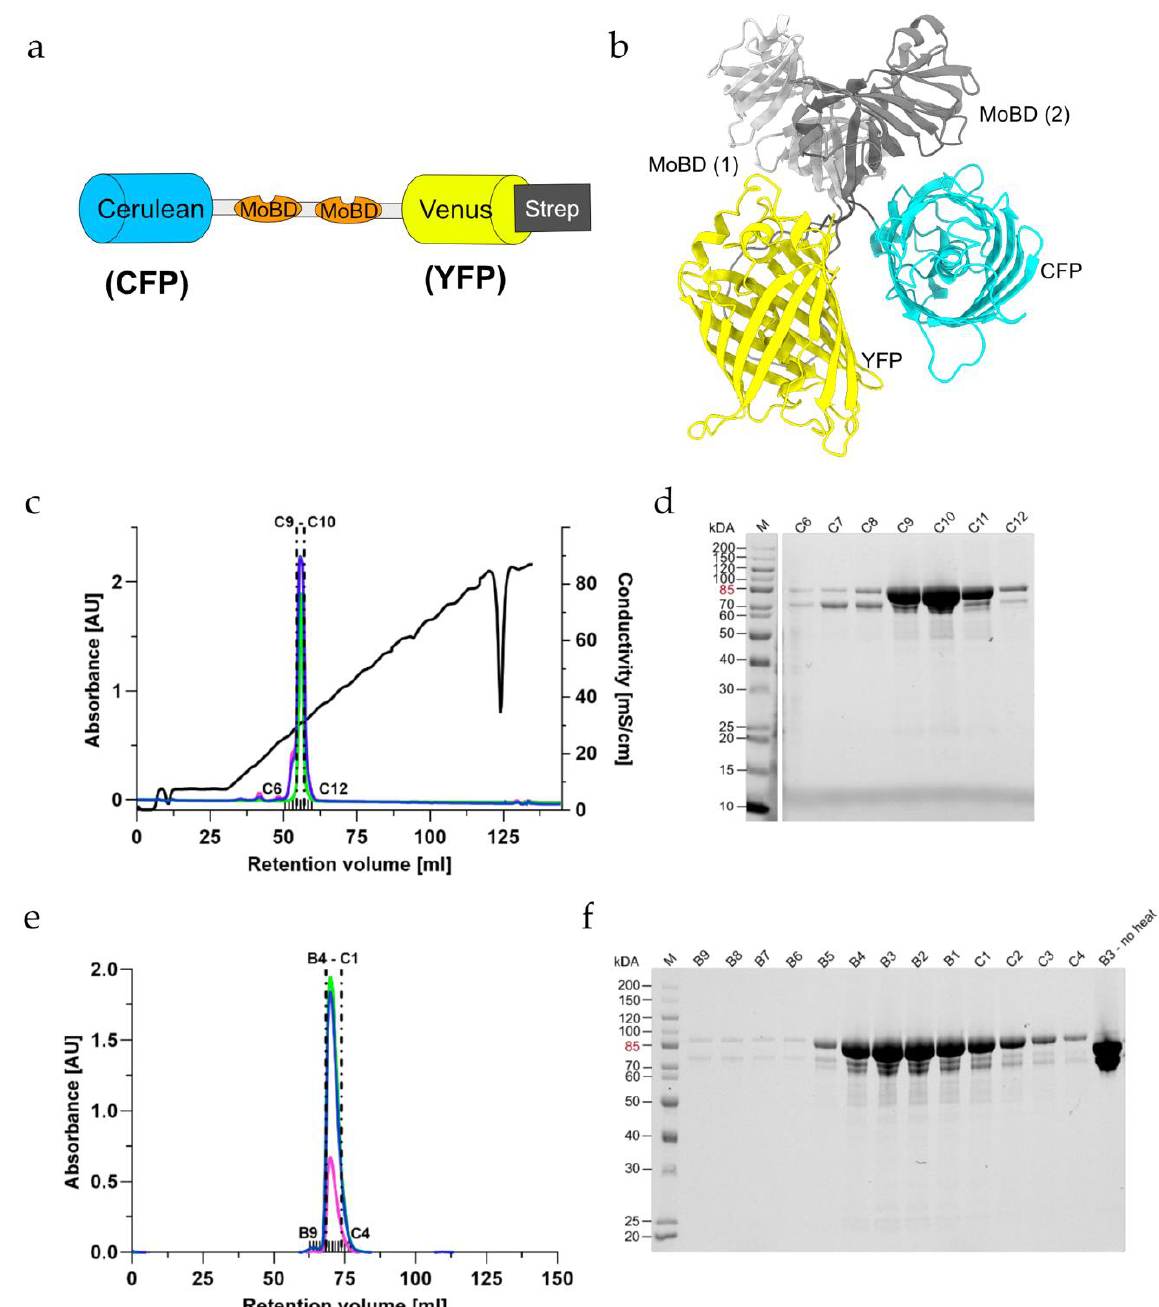
Figure 1. Purification of the MolyProbe-Strep protein: ( a ) Schematic description of the MolyProbe- Strep construct; ( b ) MolyProbe structure predicted with ColabFold; ( c ) Elution profile of the SOURCE 15Q (GE Healthcare) column; ( d ) SDS-PAGE of the selected elution fractions left to right: Ladder (M) (Pierce Unstained Molecular weight ladder, Thermo Fischer Scientific), C6 to C12; ( e ) Elution profile of a HiLoad 16/600 Superdex 200 pg (GE Healthcare) column; ( f ) SDS-PAGE of the selected fractions from left to right: Ladder (M), B9 to C4, fraction B3 not heated. Lines indicate absorbance in [AU] at (blue) 280 nm, (green) 434 nm, (pink) 515 nm and (black) conductivity in [mS/cm]. The analyzed fractions are marked above the x -axis, and the analyzed fractions are indicated with dotted